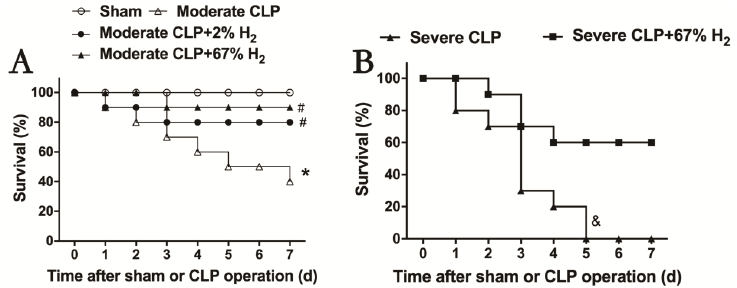
Figure 1. Hydrogen inhalation improved the survival rate of sepsis mice. ( A ) 2% and 67% hydrogen inhalation could significantly improve the 7-day survival rate of sepsis mice. ( B ) 67% hydrogen inhalation improved the survival rate of severe sepsis mice. * p < 0.05 vs. Sham group. # p < 0.05 vs. moderate CLP group. & p < 0.05 vs. Severe CLP group. 3.3. A Total of 67% Hydrogen could Significantly Reduce Sepsis-Induced Organ Injury Compared with 2% Hydrogen Septic mice showed significant pulmonary dysfunction 24 h after the operation (Figure 2). Compared with Sham group, the protein content in broncholavage fluid, lung wet-to-dry ratio and lung MPO activity of mice in CLP group increased significantly ( p < 0.05, Moderate CLP vs. Sham; p < 0.05, Severe CLP vs. Sham). Compared with the Moderate CLP group, 2% and 67% hydrogen inhalation could reduce the increase in the above indexes ( p < 0.05, Moderate CLP + 2% H 2 vs. Moderate CLP; p < 0.05, Moderate CLP + 67% H 2 vs. Moderate CLP), and 67% hydrogen inhalation exert a stronger effect on improving moderate sepsis-induced acute lung injury than 2% hydrogen ( p < 0.05, Moderate CLP + 67% H 2 vs. Moderate CLP + 2% H 2 ). At the same time, 67% hydrogen inhalation can alleviate the increase in lung injury indexes in severe septic mice compared with the Severe CLP group ( p < 0.05, Severe CLP + 67% H 2 vs. Severe CLP) (Figure 2A – C). There are pathological changes in lung of sepsis mice, such as bleeding, consolidation, alveolar and pulmonary interstitial neutrophil infiltration, alveolar wall thickening and so on. Compared to CLP group, 2% and 67% hydrogen inhalation can improve the lung pathological changes and reduce the histological score of moderate sepsis mice ( p < 0.05, Moderate CLP + 67% H 2 vs. Moderate CLP group; p < 0.05, Moderate CLP + 2% H 2 vs. Moderate CLP) (Figure 2D,E). Meanwhile, 2% and 67% hydrogen inhalation could significantly improve the indexes of liver and kidney function injury in moderate CLP ( p < 0.05, Moderate CLP + 2% H 2 vs. Moderate CLP; p < 0.05, Moderate CLP + 67% H 2 vs. Moderate CLP), and 67% hydrogen inhalation had better protective effect ( p < 0.05, Moderate CLP + 67% H 2 vs. Moderate CLP + 2% H 2 ); Compared with the severe sepsis group, high concentration hydrogen inhalation significantly improved liver and kidney function injury in severe septic mice ( p < 0.05, Severe CLP + 67% H 2 vs. Severe CLP) (Figure 2F – H).